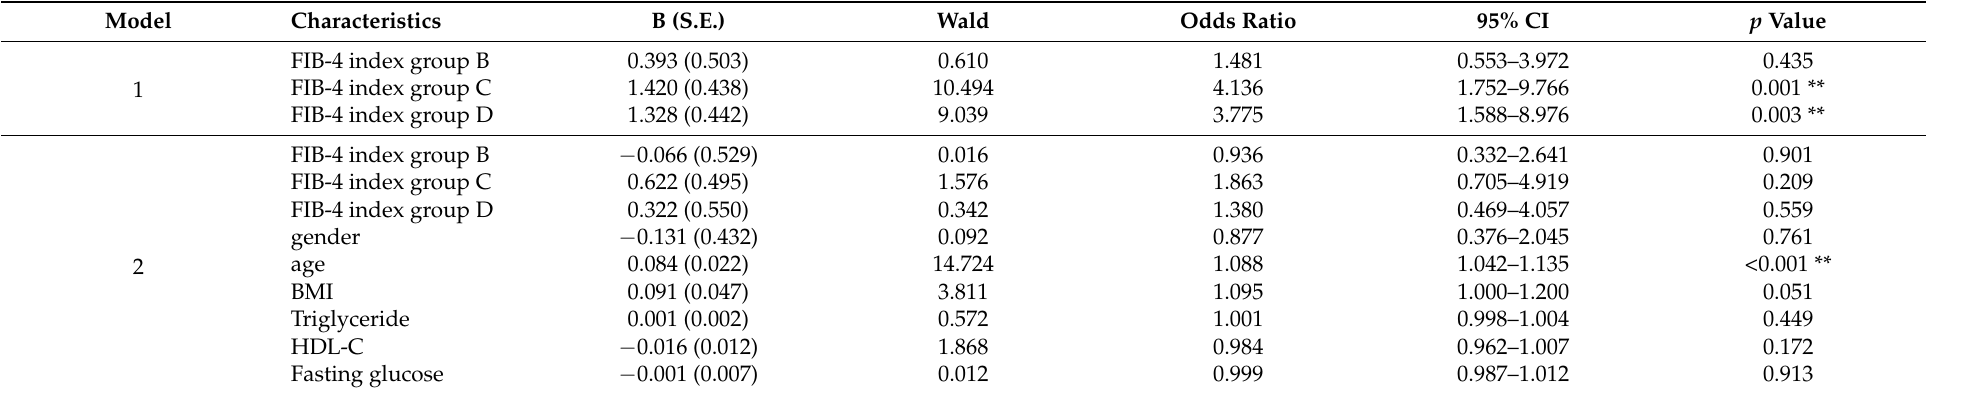
Table 2. Multivariable analysis of odds ratio for CKD stage 3–5 in Study